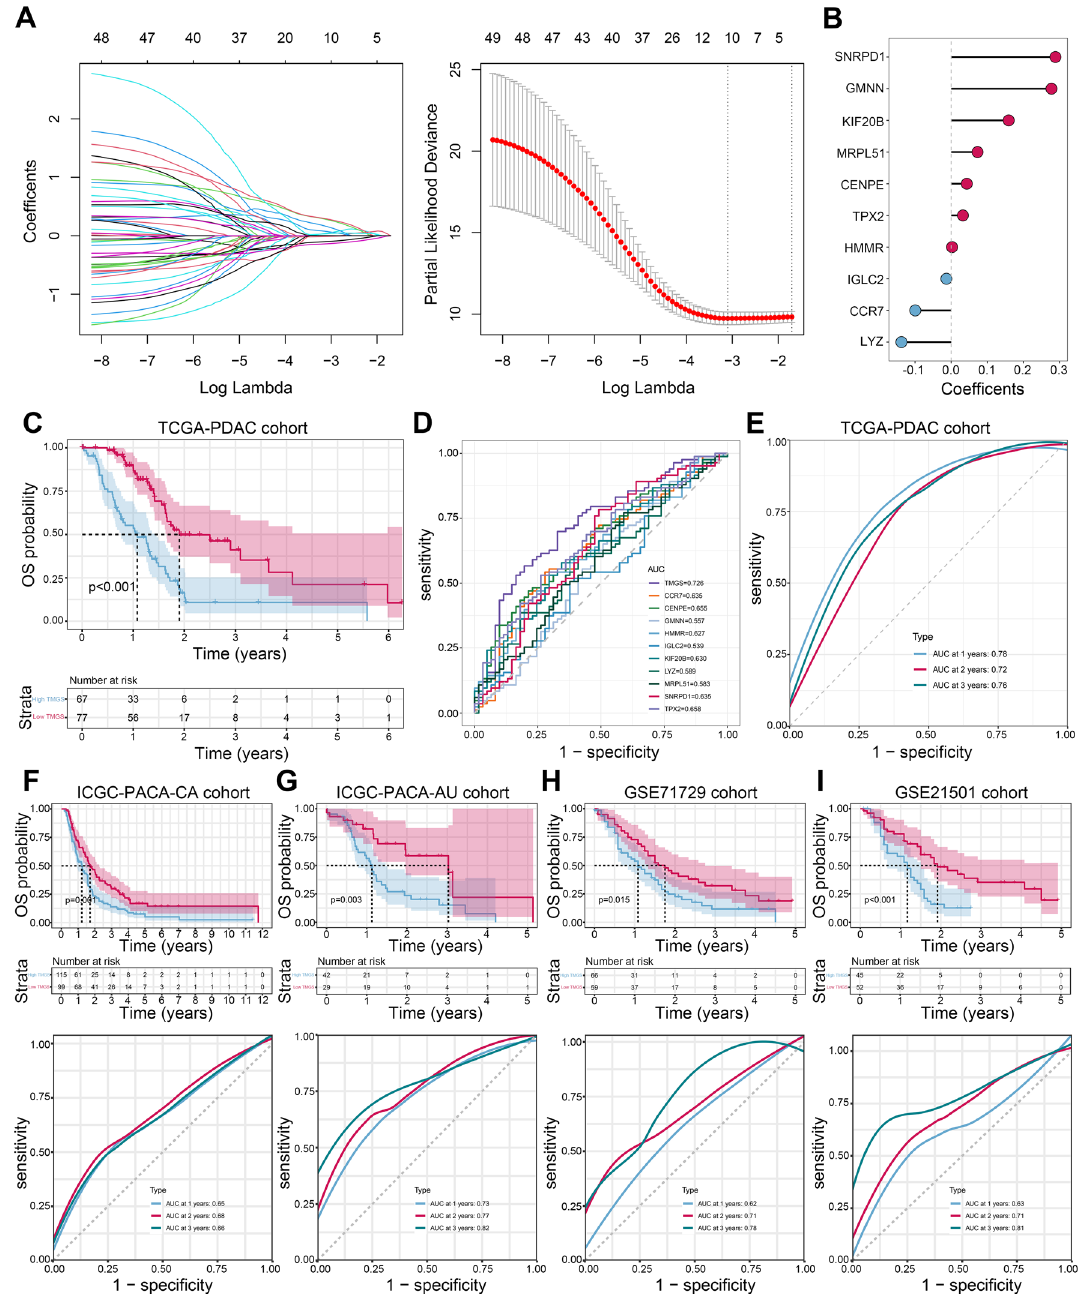
Figure 4. TMGS identification and validation in multi-omics datasets. ( A ) LASSO regression identifies 10 optimal TMGs to develop TMGS. The left panel represents the variable selection process during LASSO regression. The horizontal axis is the penalized parameter lambda after log transformation. The vertical axis is the coefficients of each variable. The coefficients gradually tended to zero with the increment of lambda. Eventually, variables with nonzero coefficients were selected for further analysis. The right panel is the tenfold CV of the LASSO model. ( B ) Dot plot to display the coefficients of the LASSO-identified 10 TMGs. Blue color represents coefficients less than 0, while red color represents coefficients greater than 0. ( C ) Kaplan–Meier survival curve with log-rank test indicated that high TMGS is correlated with poor OS in PDAC. ( D ) ROC curves of TMGS and each TMGs to compare their performance in predicting the clinical outcome of PDAC. ( E ) time-dependent ROC curves to evaluate the performance of TMGS in predicting the 1-, 2-, and 3-year OS probability of PDAC. ( F–I ) External validation of the risk stratification ability and 1-, 2-, and 3-year OS probability prediction ability of the TMGS in ICGC-PACA-CA ( F ), ICGC-PACA-AU ( G ), GSE71729 (H),